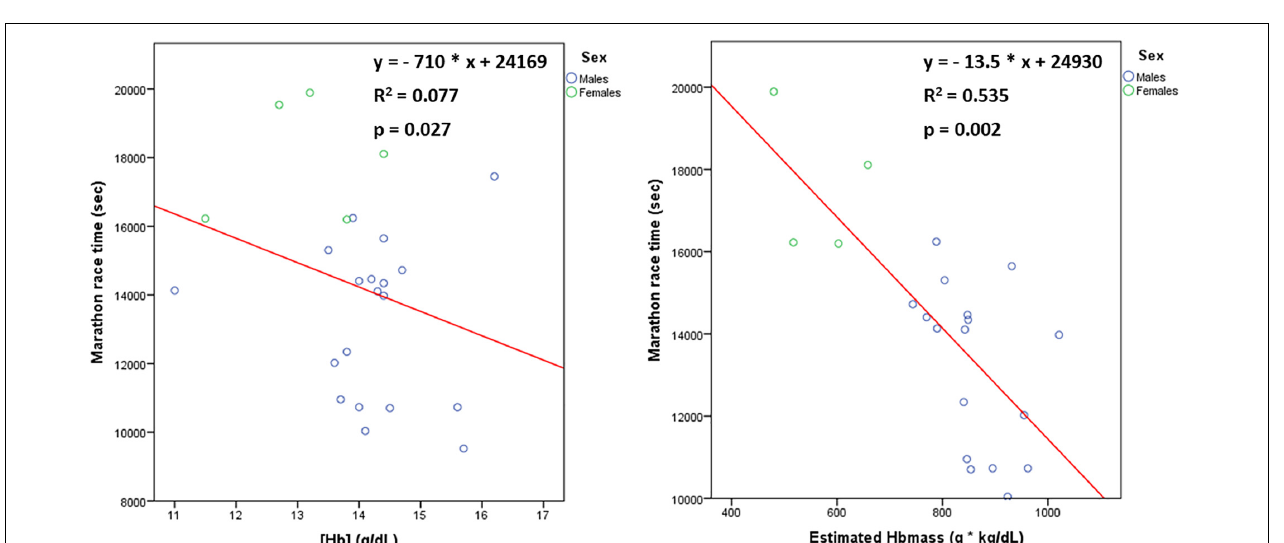
( p = 0.006), indicating good discriminatory ability for